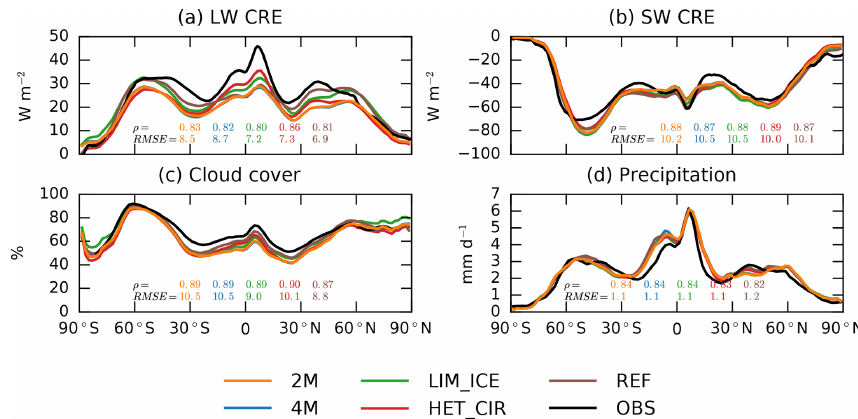
Figure 4. The 10-year zonal mean values for longwave (LW CRE) and shortwave cloud radiative effects (SW CRE) (a, b) and total cloud cover and precipitation (c, d) . The coloured lines show simulations of different configurations of the new model in Table 2. Black lines show satellite products. For CRE we show data from CERES EBAF (2000 to 2017). Total cloud cover is shown for CALIPSO-GOCCP (2006 to 2012) and the model data are produced using the COSP-simulator. Precipitation data are from the GPCP (2003 to 2012). The Pearson correlation coefficient and root mean square error are reported by text in matching colours for the different simulations and computed using the full two-dimensional fields. Table 3. The 10-year global average values for a selection of key microphysical parameters for the model configurations presented in Table 2. Observational data are used from the compilation of Lohmann and Neubauer (2018) with the exception of ice water contents where we use the dataset of Li et al. (2012) and report their average standard